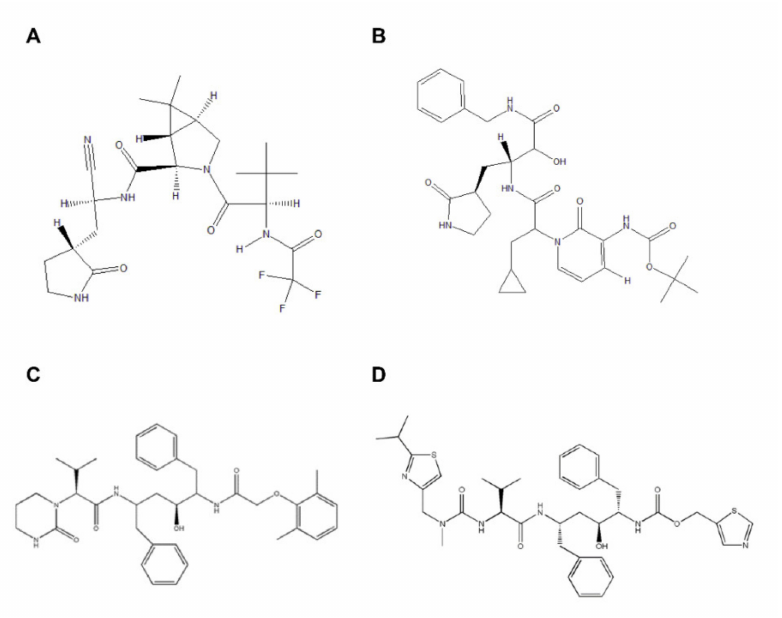
Figure 1. 2D structure representation of ( A ) PF-07321332, ( B ) α -ketoamide, ( C ) lopinavir, and ( D )